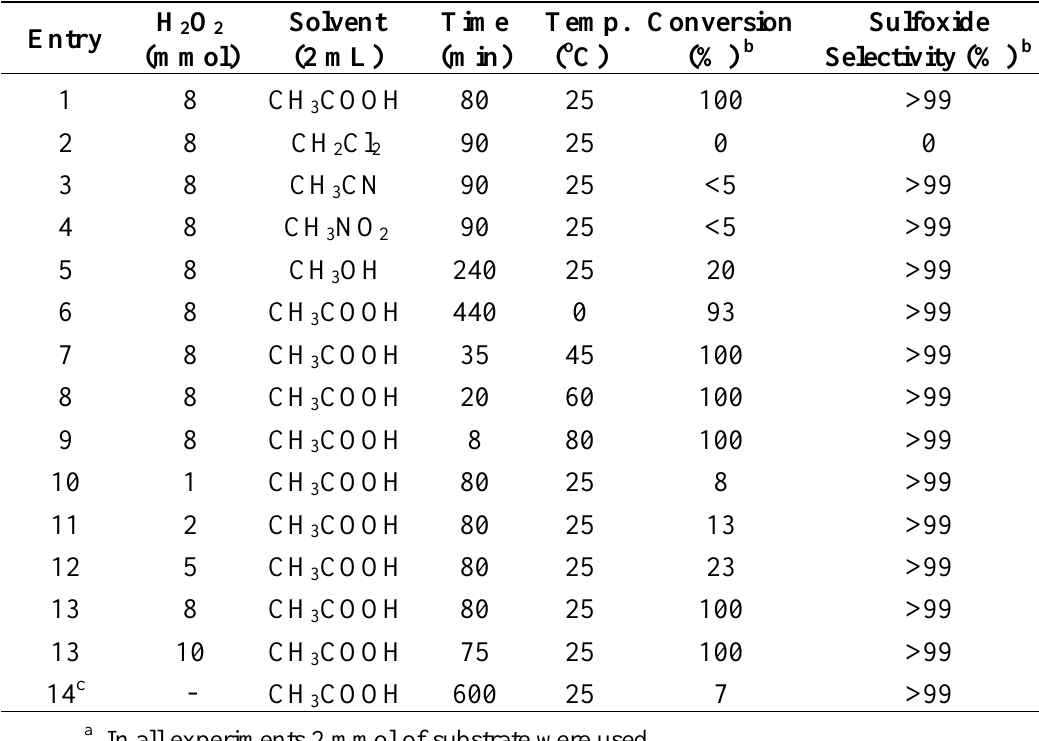
Table 1 . Oxidations of methyl phenyl sulfide a .